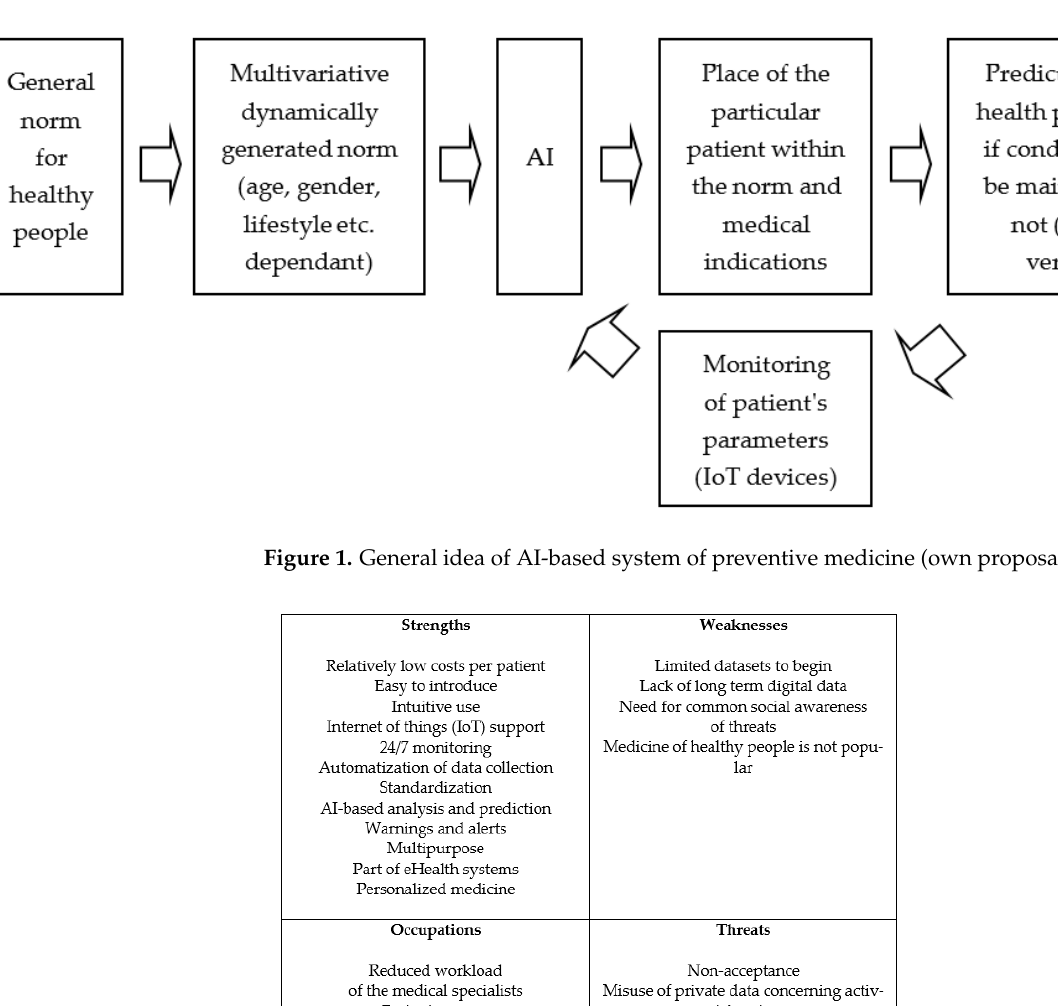
Figure 2. SWOT analysis for AI-based system of preventive medicine.